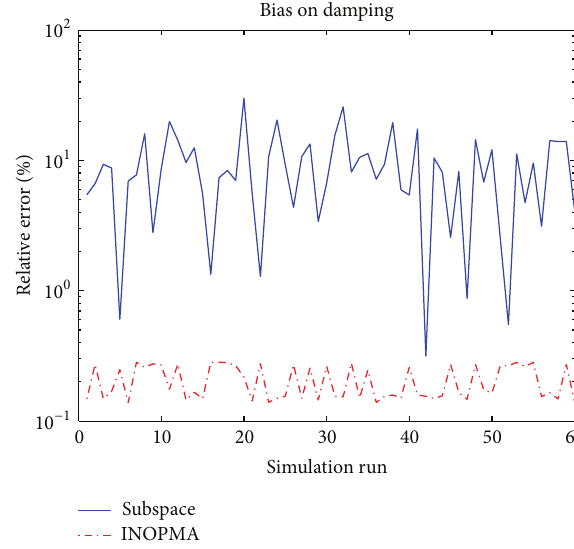
Figure 8: Absolute value of the relative error on